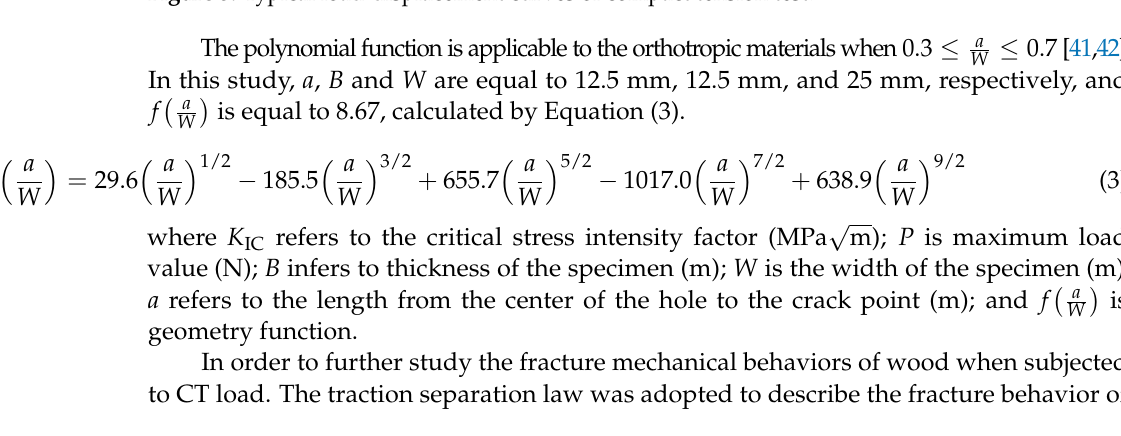
Figure 5. Typical load-displacement curves of compact tension test.